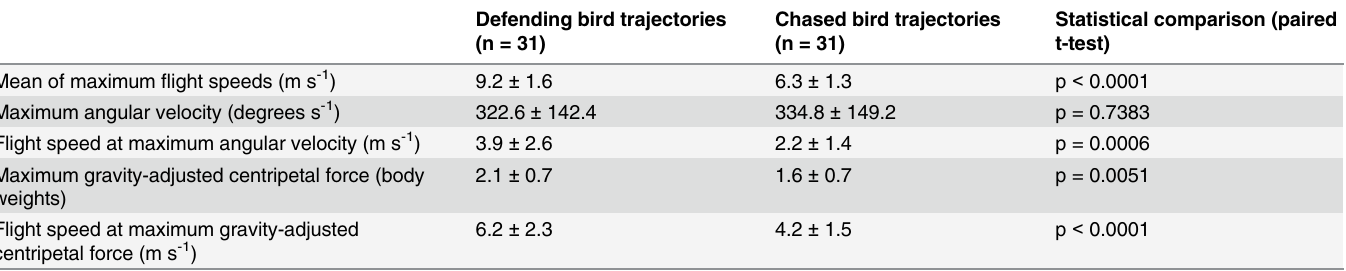
Table 3. Defending vs . Chased bird trajectories.